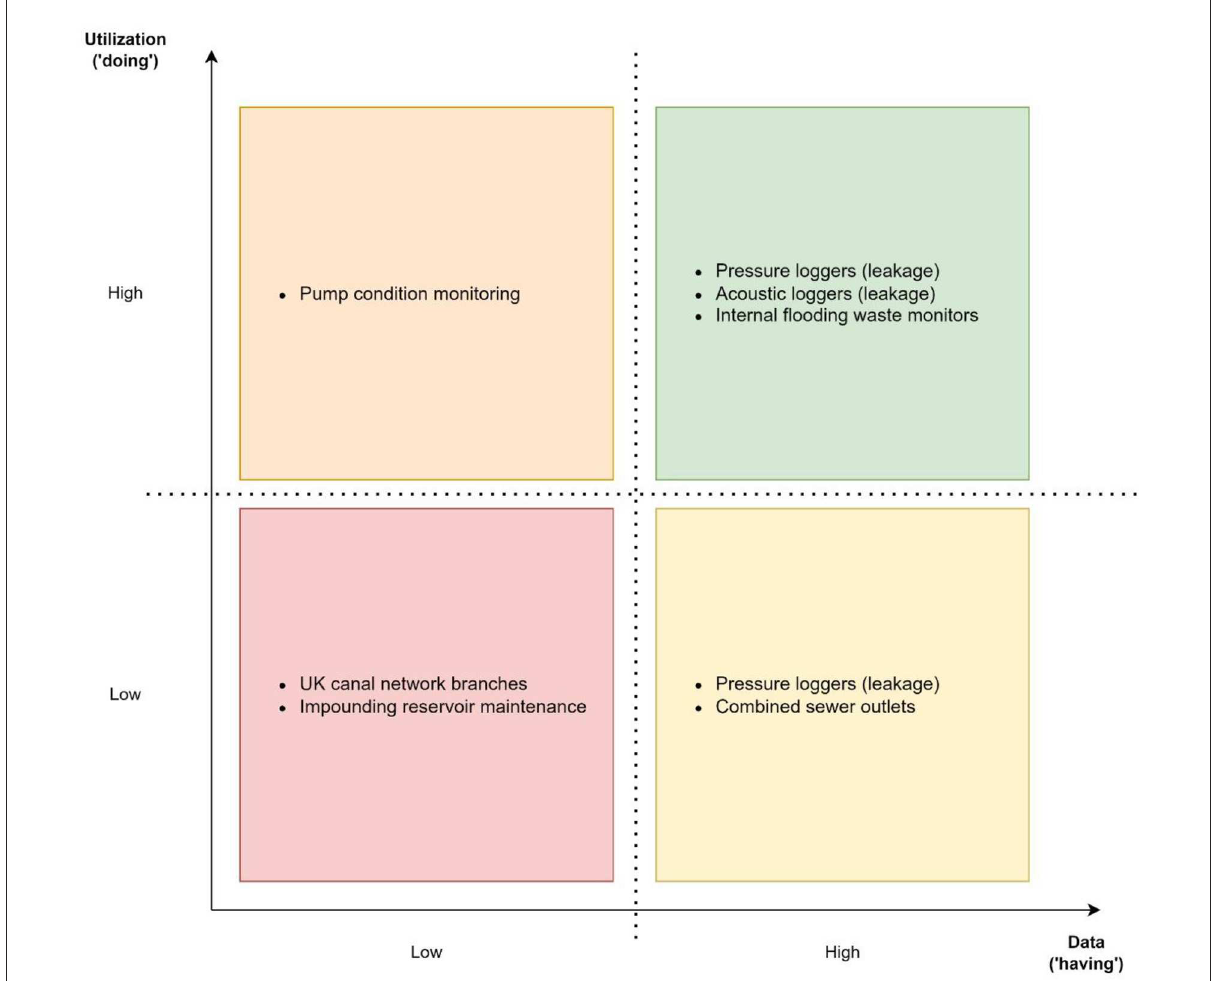
FIGURE4 Real-world applications of data collection and analysis applied to water